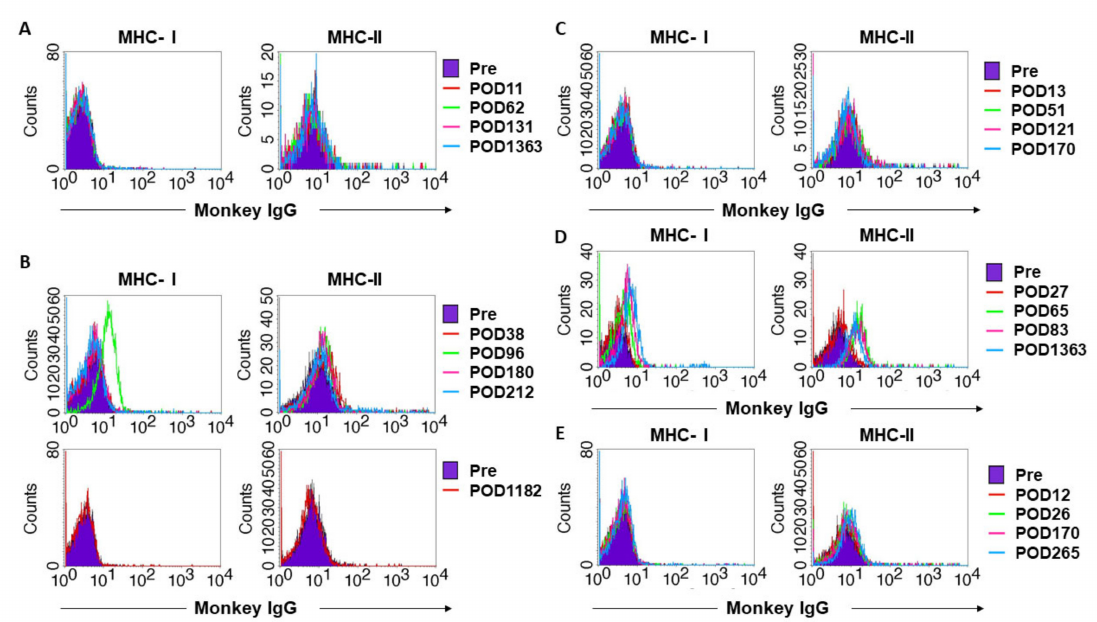
Figure 9. Antibody responses against donor cells in case 1 ( A ), case 2 ( B ), case 3 ( C ), case 4 ( D ), and case 5 ( E ). FITC-labeled anti-monkey IgG antibodies were used as secondary antibodies. After gating at CD3-positive lymphocytes and CD20-positive lymphocytes, we made FITC-histograms to analyze IgG specific for each lymphocyte. Histograms of MHC-I (left) and MHC-II (right) exhibiting IgG antibodies specific for donor cells gated by CD3 + cells and CD20 + cells, respectively. In case 2, DSA specific for MHC class II was detected on POD 38, in addition to which DSA specific for MHC class I was detected on POD 48 (data not shown). Higher levels of DSA specific for MHC class I was detected on POD 96. Thereafter, the titer of MHC-class I-specific DSA gradually decreased and vanished on POD 180 when PTLD occurred, while low levels of MHC class II-specific DSA remained ( B ; upper panel). After PTLD was treated, MHC class I and II-specific DSA were not detected until delivery during the period from POD 212 to POD 1182 ( B ; lower panel). In case 4, in which a uterus with full-mismatched MHCs was transplanted, DSA was detected on POD 65 and similar levels of DSA was also detected on POD 83 and 101 ( D ). Low levels of MHC class I and II-specific DSA were detected in case 5, in which a uterus with mismatched MHC, except for one locus of MHC class IB, was transplanted ( E ). DSA was not detected in cases 1 and 3, in which multiple loci of MHC were matched between donor and recipient. ( A , C